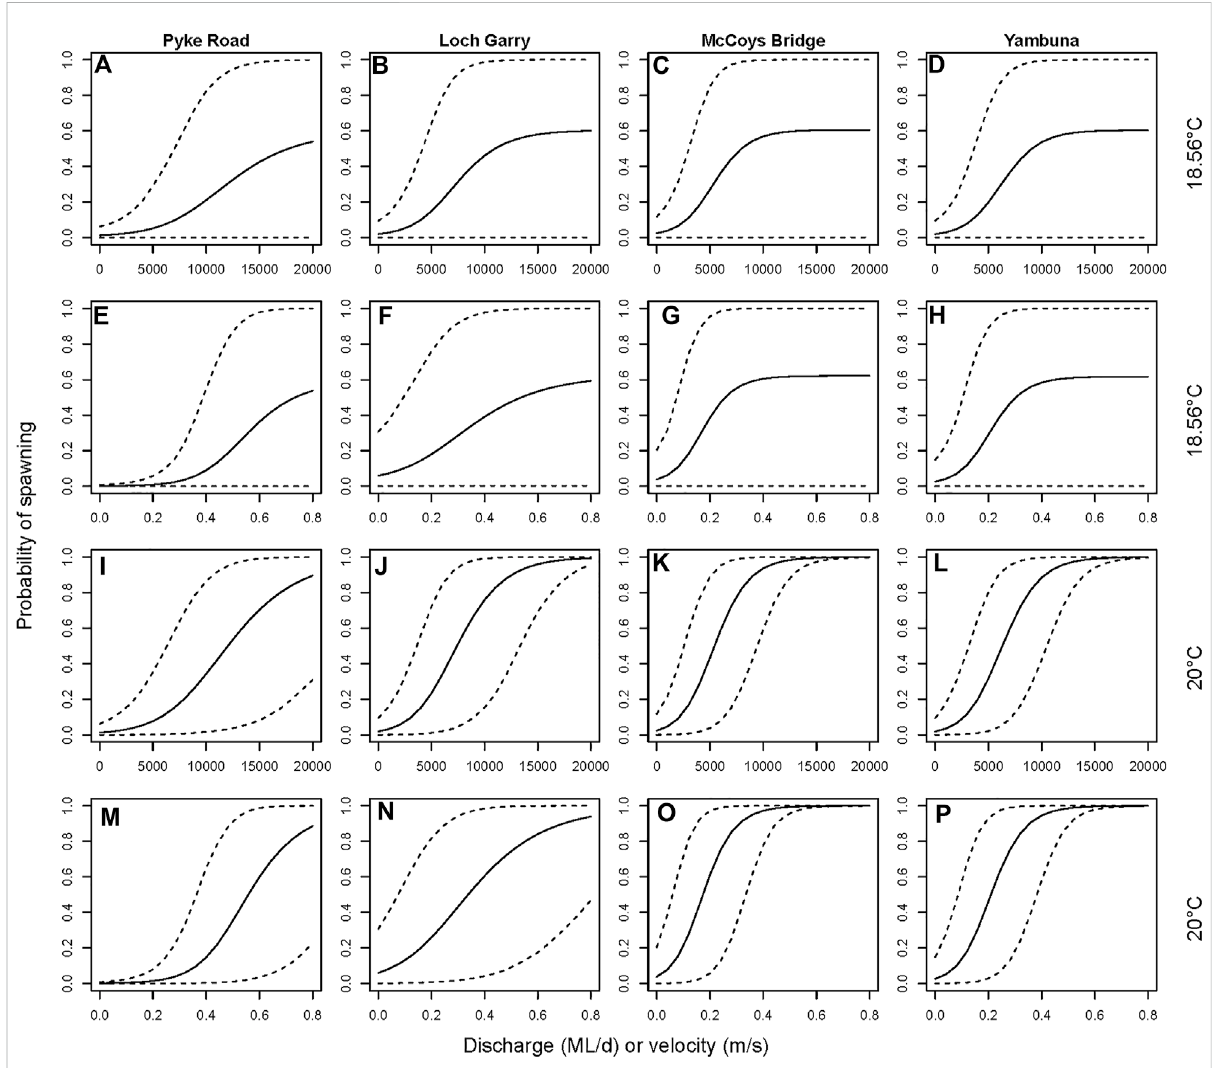
FIGURE 8 Graphs show the estimated probabilities of spawning at different combinations of fl ow and temperature. Predictions are based on the two models that incorporated antecedent fl ows ( Q 5 wk ) and are predicted for the mean Q 5 wk across the data set. Y axes are the estimated probabilities and x -axes are the discharge (ML · d − 1 , panels (A – D) , (I – L) and Velocity (m · s − 1 , panels (E – H) , (M – P) . The x -axis limits are approximately equivalent at the mid-points (i.e. 10,000 ML d − 1 ≈ 0.40 m s − 1 ) for the hydraulic models for Loch Garry and McCoys Bridge (Figure 2). Solid line is the median estimate of probability with the dotted lines encompassing the 95% credible interval of the estimate. Columns show the different sites, with the fi rst two rows being predictions at the approximate median estimate for Te. crit of 18.56 ° C and rows three and four being predictions at 20.0 ° C. Within each temperature, the pair of graphs for each site compares the predictions for the discharge-based model (Q; panels (A – D) , (I – L) and reach- averaged velocity-based model (V; panels (E – H) , (M – P)